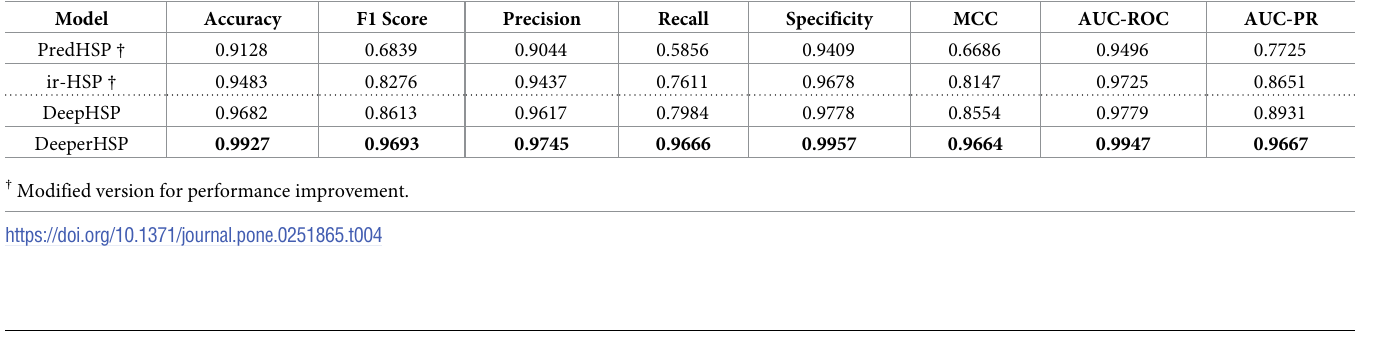
figurations: 12 points of regularization penalty C and kernel coefficient γ that were evenly spaced between 10 3 and 10 − 3 .